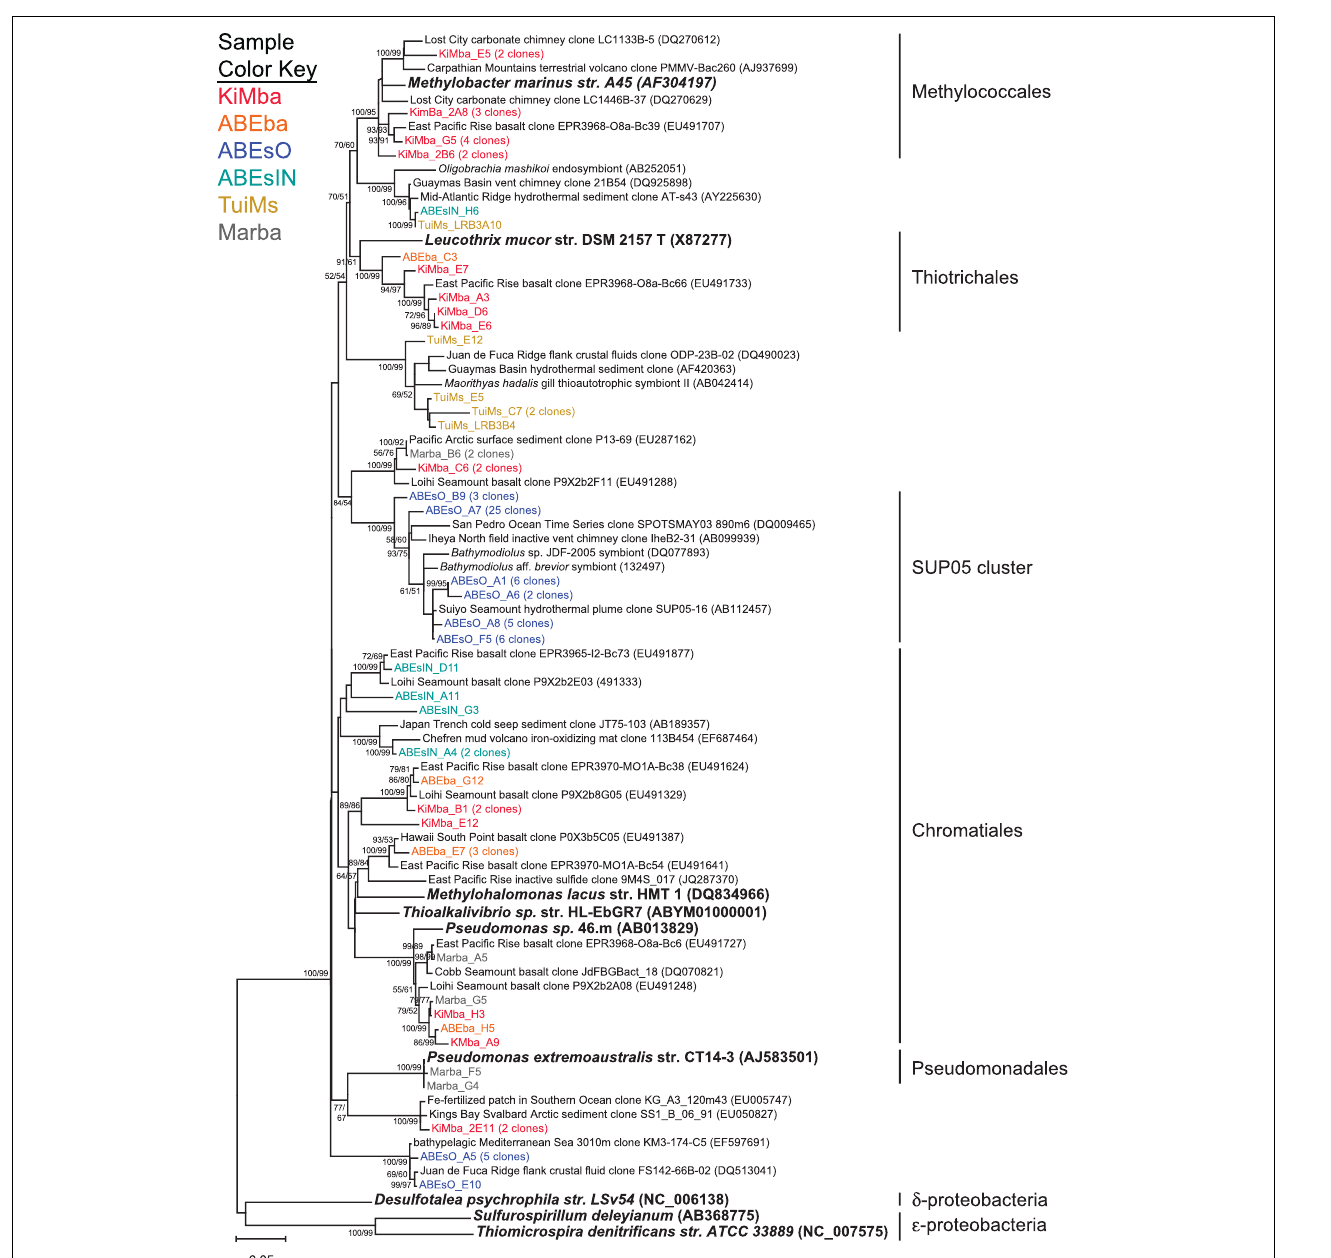
was used to generate a neighbor-joining tree with the maximum composite likelihood method and 1000 bootstrap replicates. Nodes where both methods agree and bootstrap support was > 50% are indicated with bootstrap values from the neighbor-joining tree on the left and the maximum likelihood tree on the right. Samples are color-coded and no representative clones are shared across multiple samples. D. psychrophila , S. deleyianum , and T. denitrificans were used as